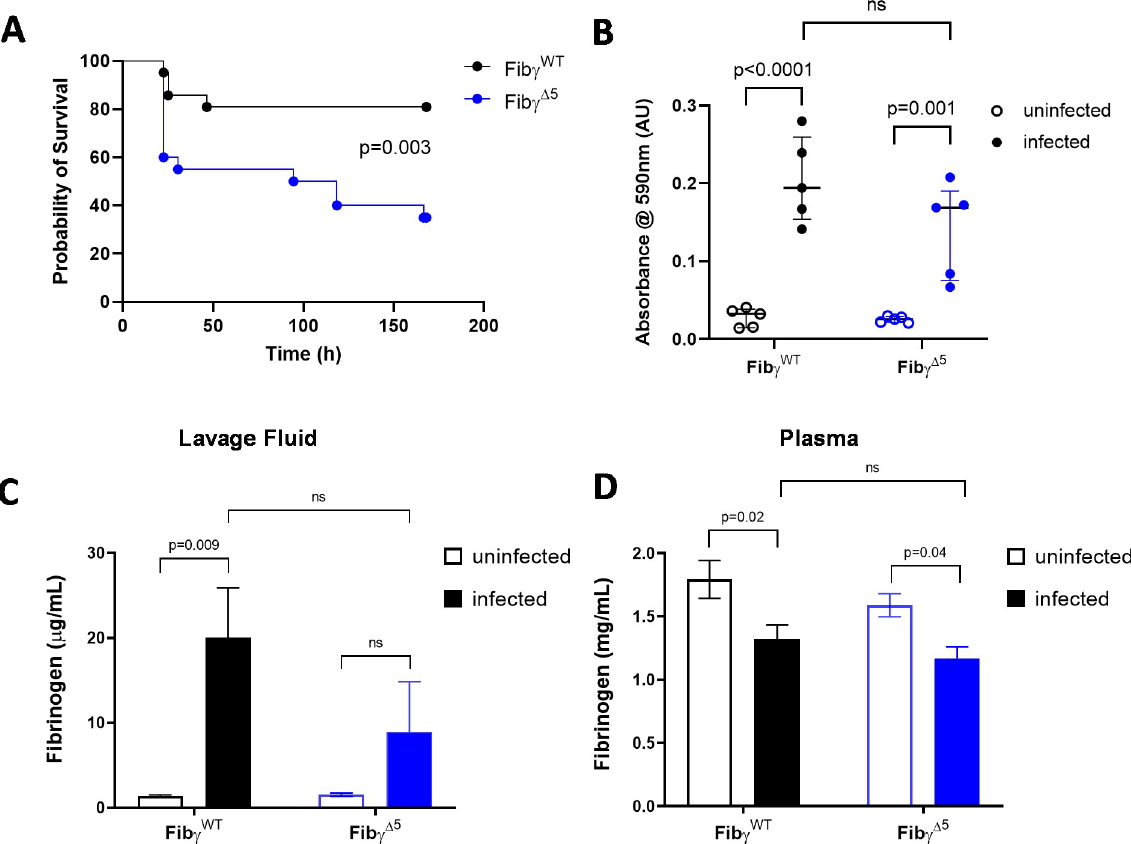
Fig 2. Fib γ Δ 5 mice display decreased survival following S. aureus peritonitis. (A) Kaplan-Meyer log-rank analysis of Fib γ WT (n = 20) and Fib γ Δ 5 (n = 20) mice following i.p. infection with 4.7x10 8 CFUs of S . aureus USA300. (B) Evans Blue vascular leak assay on Fib γ WT and Fib γ Δ 5 mice following i.p. injection with PBS or ~1x10 9 CFU of S . aureus USA300. Fibrinogen ELISA on lavage fluid (C) and plasma (D) following 1 hour i.p. infection with S . aureus USA300. Data are presented as mean ± SEM and statistical significance was determined by 2-way ANOVA with Sˇı´da´k’s multiple comparisons